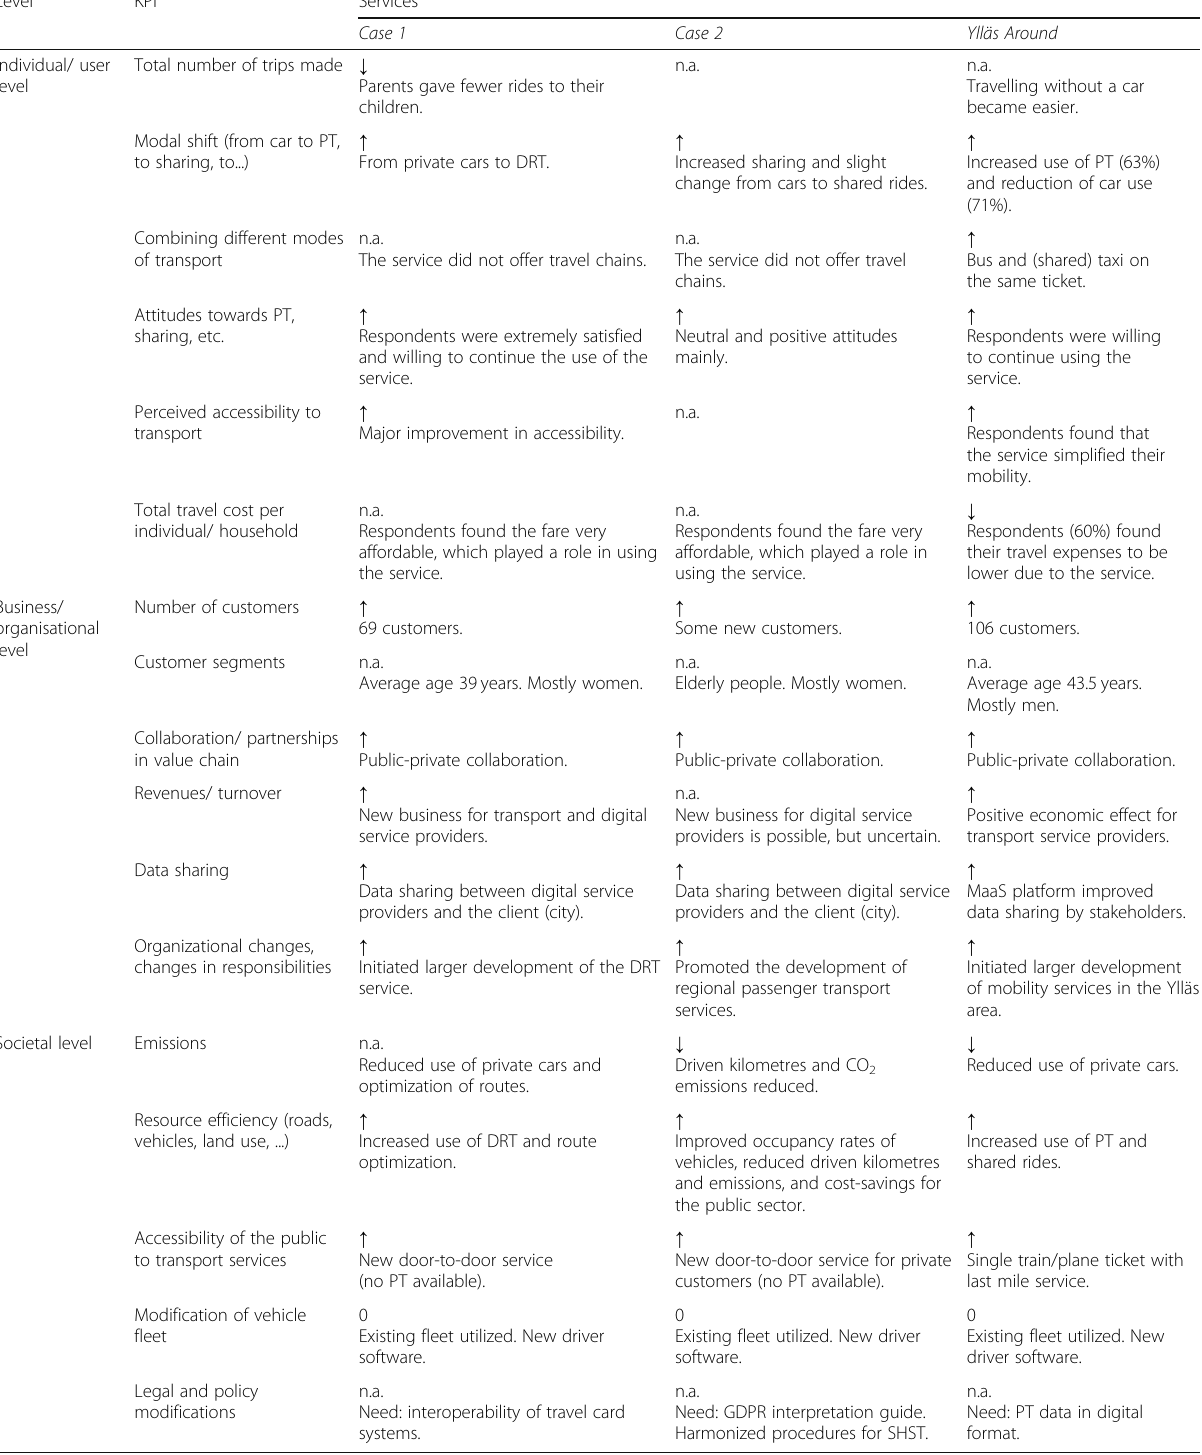
Table 6 Comparison of Case 1, Case 2 and Ylläs Around impacts, ( ↑ ) = increase, ( ↓ ) = decrease, 0 = no change, n.a. = no information available (adopted partly from [12]) Level KPI Services Case 1 Case 2 Ylläs Around Individual/ user Total number of trips made ↓ level Parents gave fewer rides to their